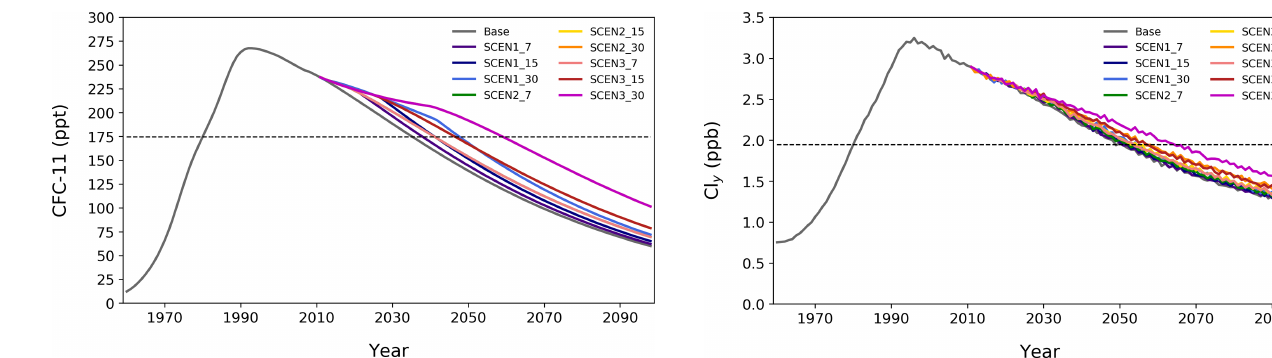
Figure 3. Modelled annual mean 40 km inorganic chlorine (Cl y ) mixing ratios, averaged from 10 ◦ S–10 ◦ N, for the BASE and SCEN simulations. The dashed line represents the 1980 Cl y mixing ratio at 40km in the BASE simulation, used as the value for calculating the Cl y return